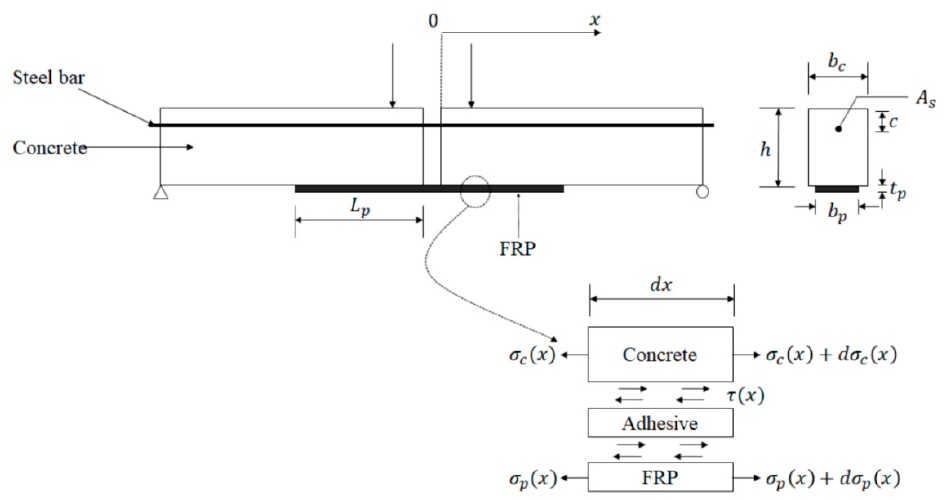
Figure 2. Schematic diagram of the FRP-concrete interface of bending test.